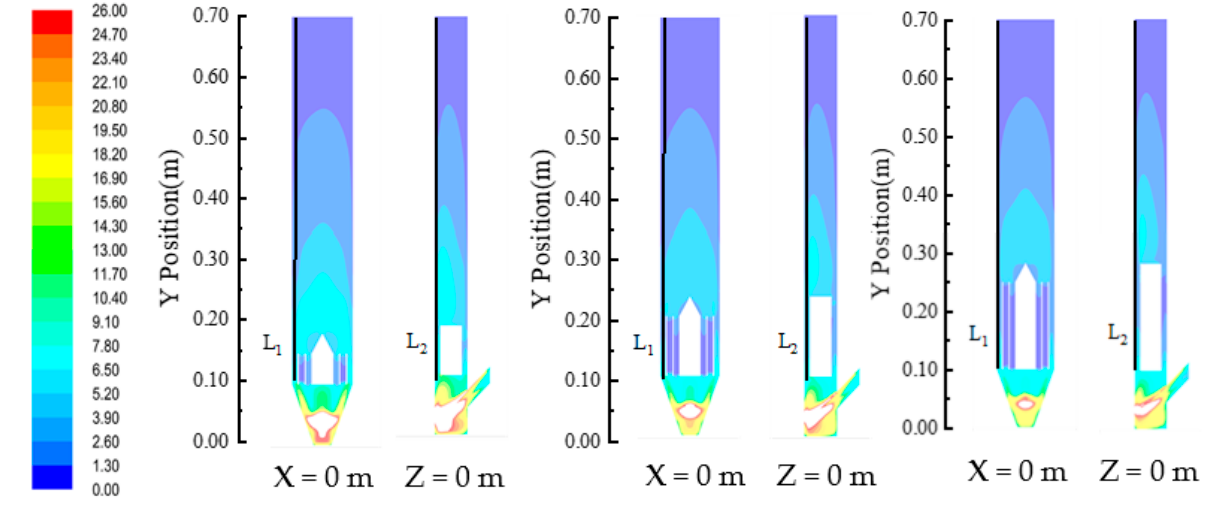
Figure 5. Distribution of turbulence intensities across different sections of the observation trough corresponding to different lengths of the TES.